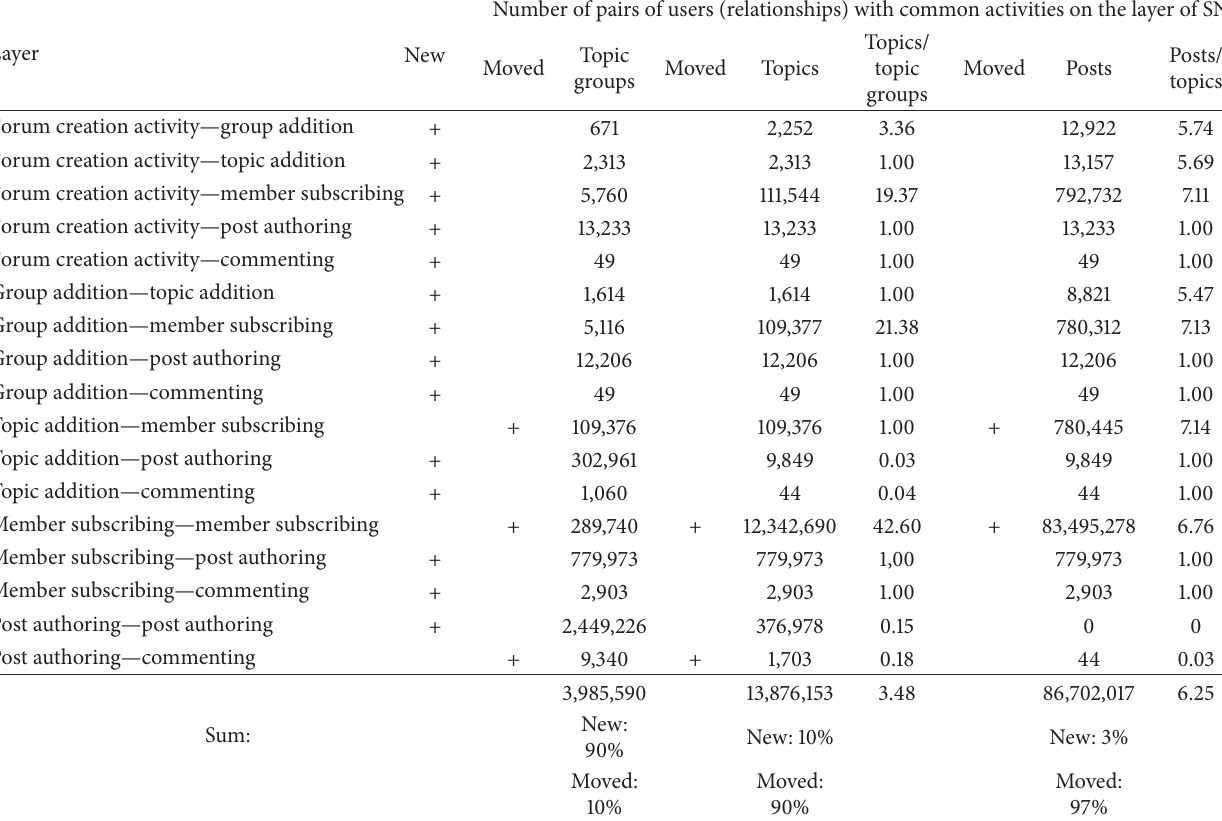
Table 5: Layers in SN and their profile for three different flattening